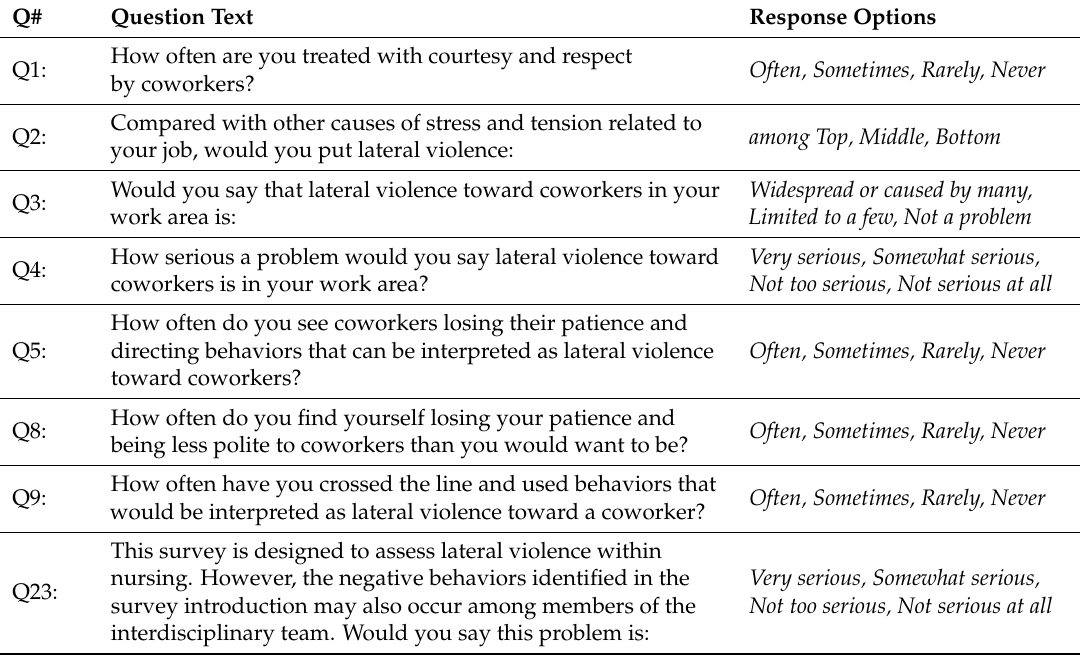
Table 2. Items that asked about the prevalence/seriousness of lateral violence in nursing.